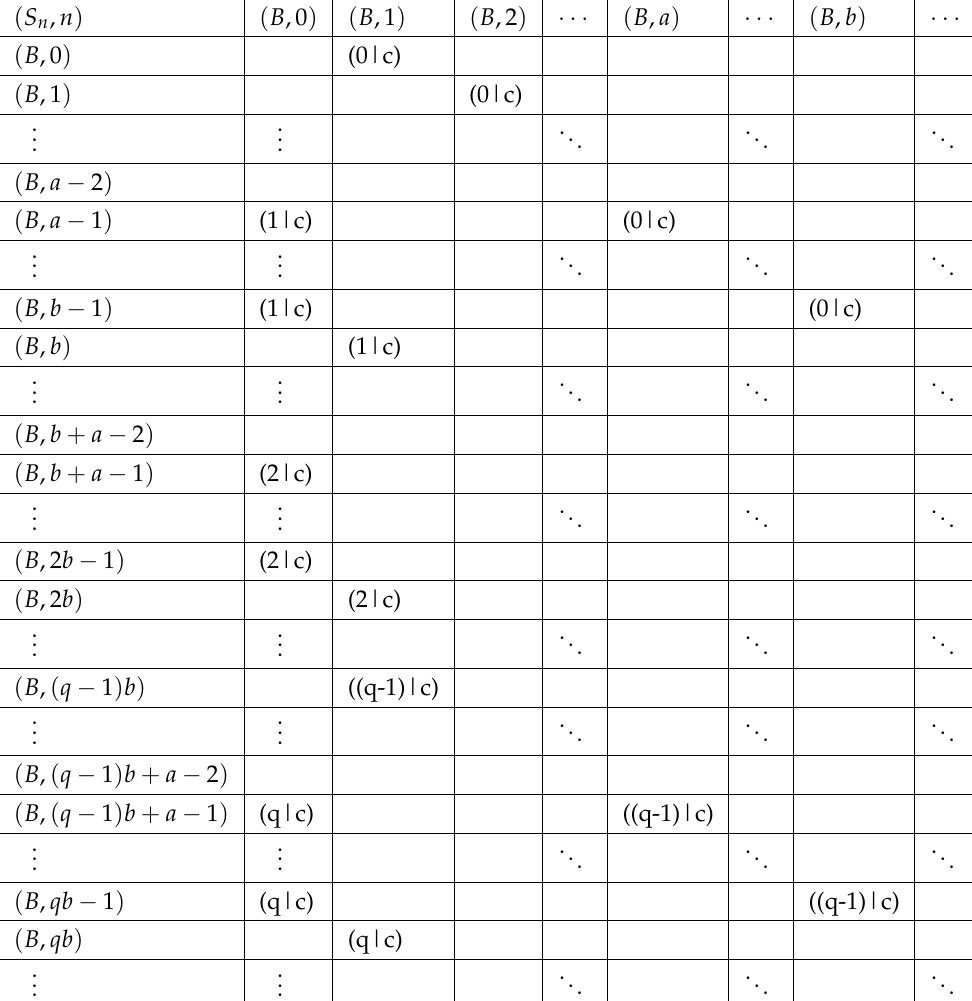
Table 3. Submatrix T Busy → Busy